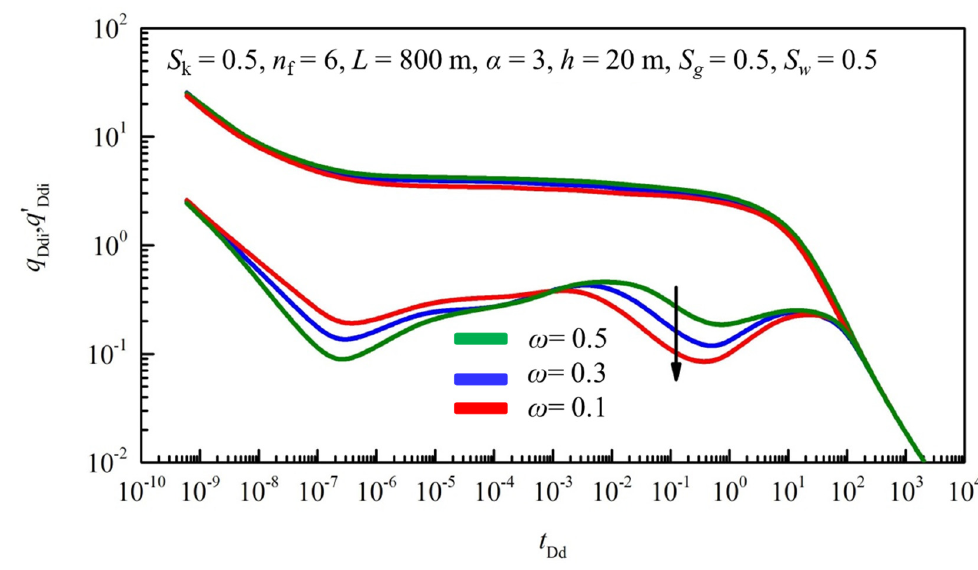
Figure 5. Effect of storage ratio on dimensionless production integrals and derivative curve.